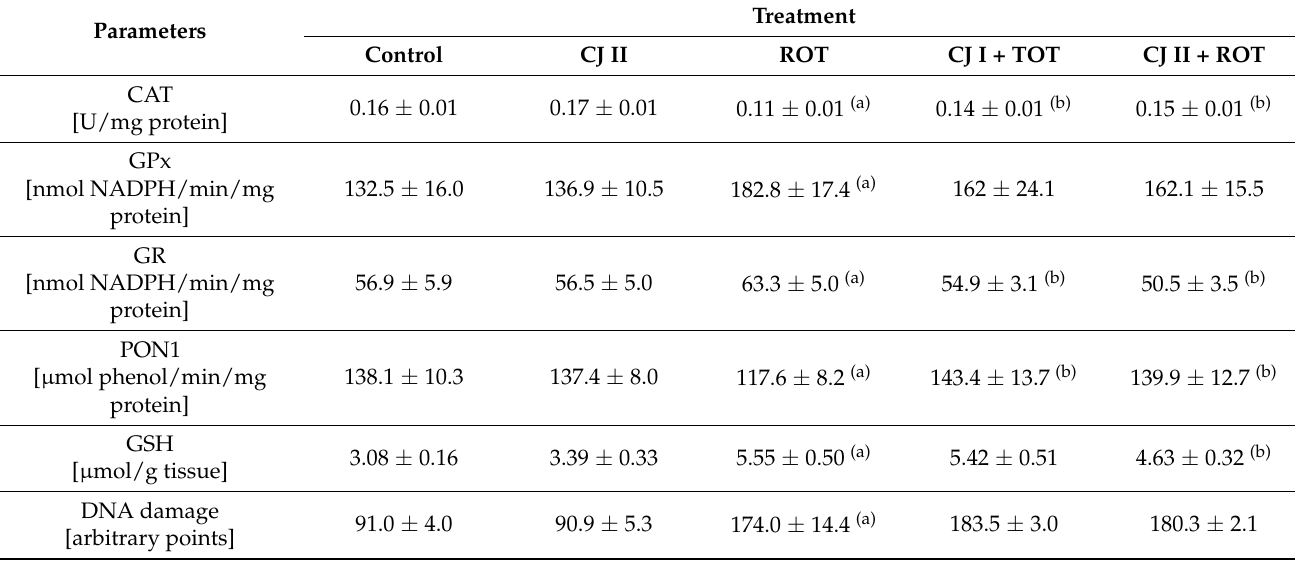
Table 4. Effect of cranberry juice (CJ) on oxidative stress markers in the kidneys of rotenone (ROT)-injected rats.